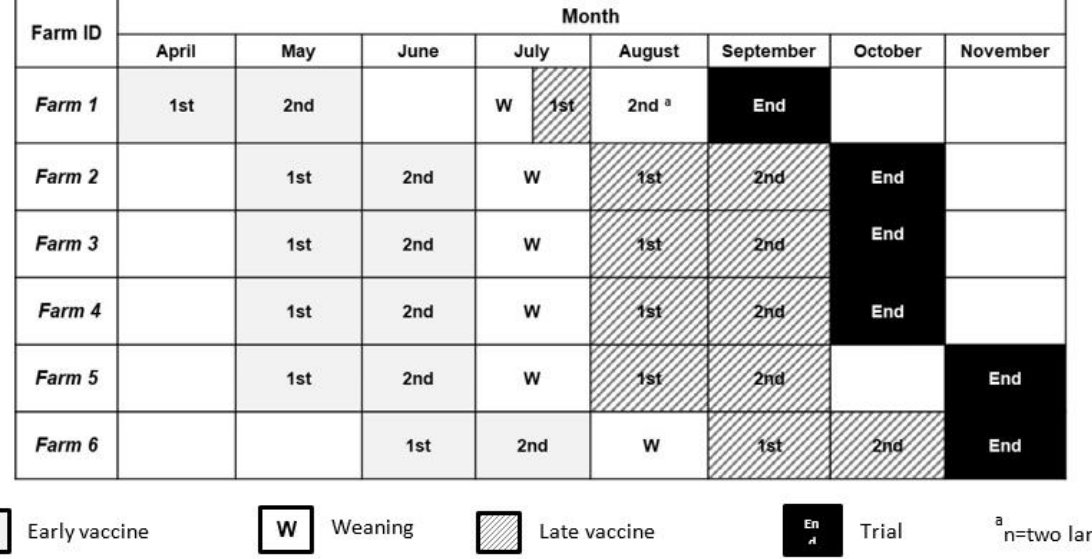
Figure 1 Schedule of timings for the first (1st) and second (2nd) vaccinations of the primary vaccine course for early and late vaccination groups, weaning and the end of trial on each of the six study